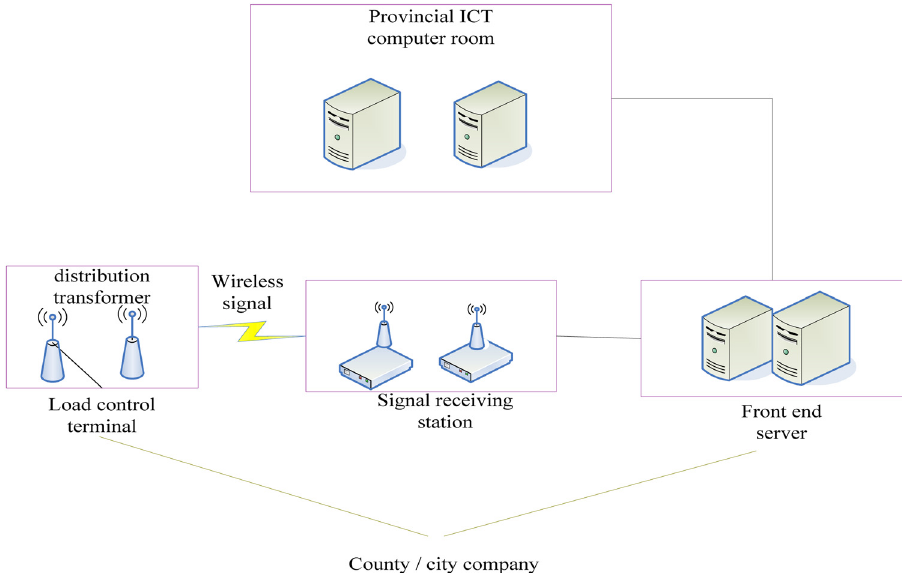
Figure 2: Electricity information collection